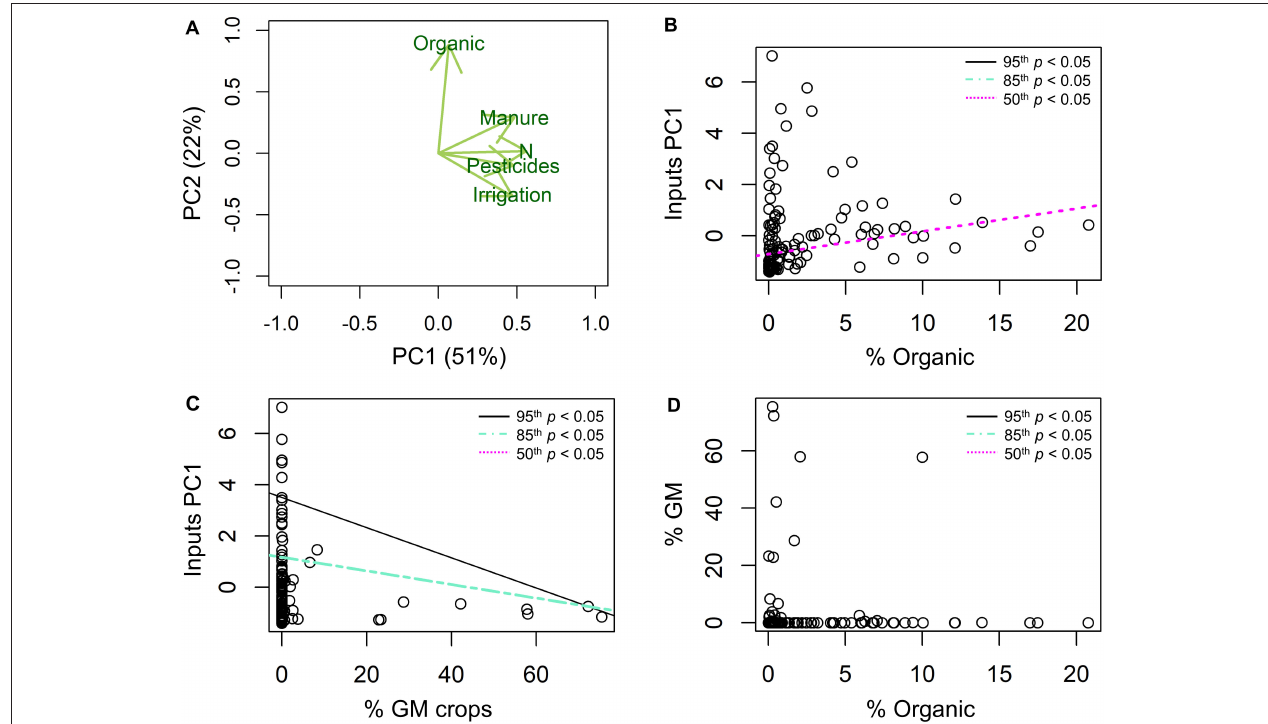
FIGURE 1 | Relationships between agricultural practices. (A) Principal components (PC) 1 and 2 showing variation (shown as % in axis labels) in five agricultural metrics: (i) share of agricultural land in organic production; (ii) share of agricultural land equipped for irrigation; (iii) synthetic nitrogen (N) input; (iv) manure applied to soils; and (v) pesticide use scaled by total agricultural area. (B–D) Quantile regressions showing relationships between agricultural practices at the 50th (pink, dotted line), 85th (teal, dashed line), and 95th (black, solid line) quantiles. (B) Percentage of agriculture in organic vs. inputs PC1, (C) percentage of crops in GM vs. inputs PC1, and (D) percentage of agriculture in organic vs. percentage of crops in GM. Lines with coefficient P > 0.05 are not shown in the figure, but all regression line estimates and errors are given in Supplementary Tables S6–S8